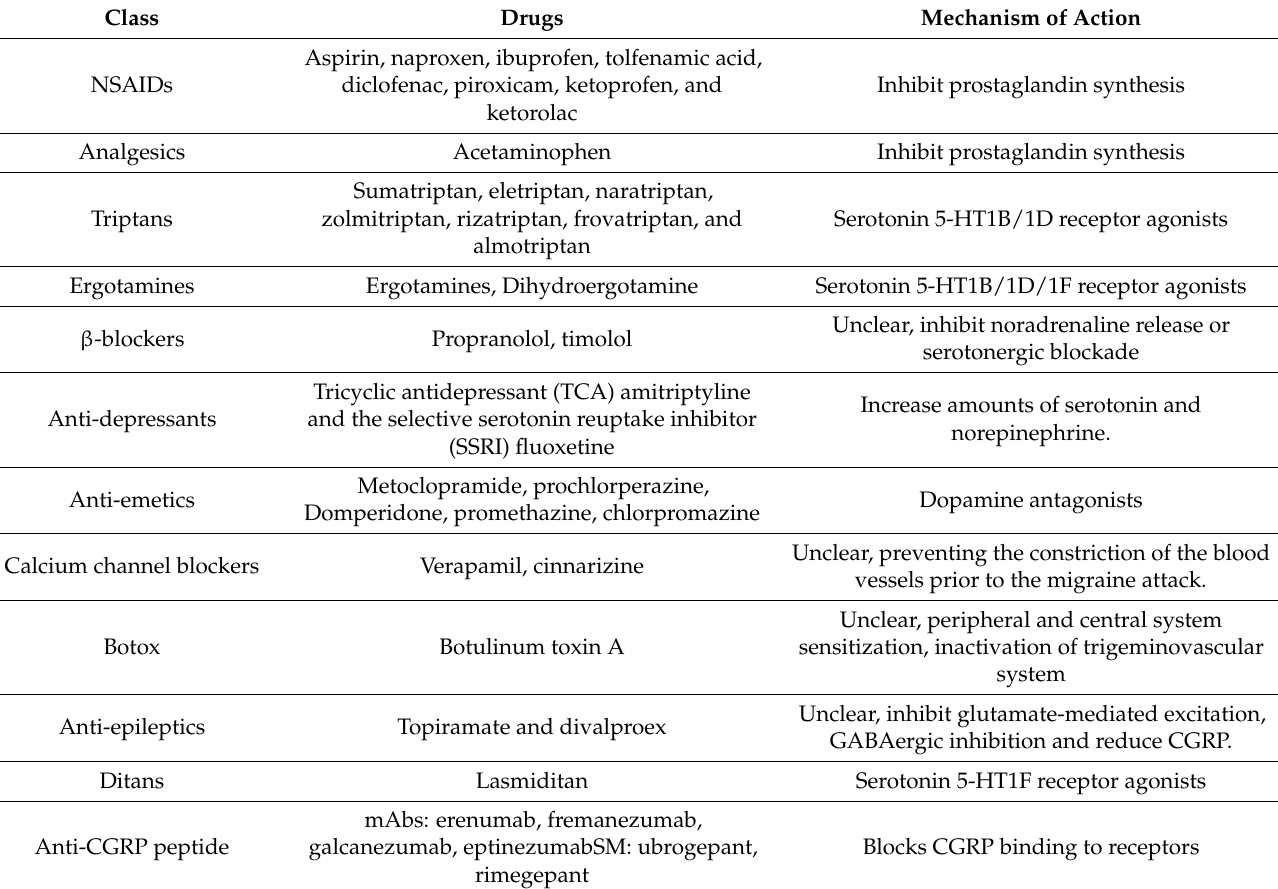
Table 9. Approved therapeutics for